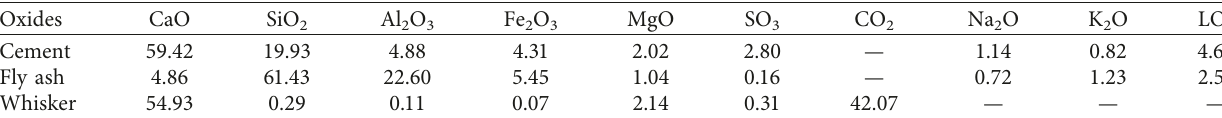
Figure 1: (a) Macroscopic and (b) microscopic images of CaCO Table 1: Chemical compositions of raw materials (wt.%).